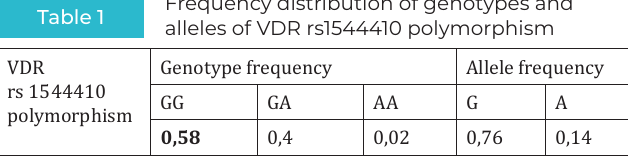
Frequency distribution of genotypes and alleles of VDR rs1544410 polymorphism